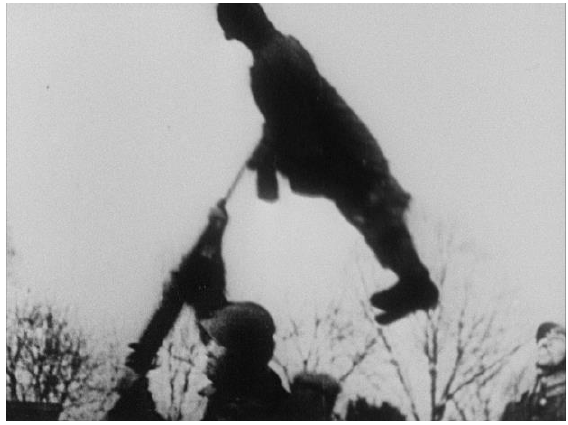
Figure 11. 'Child' (a doll) bayoneted in Chinese propa- ganda film. Source: National Film Board of Canada.